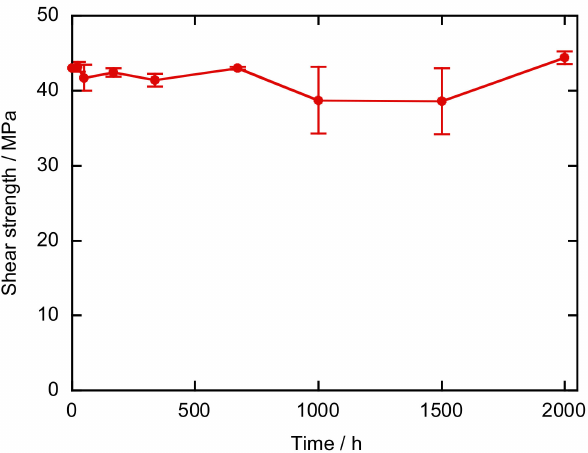
Figure 8. Variation in shear strength during high-temperature and high-humidity